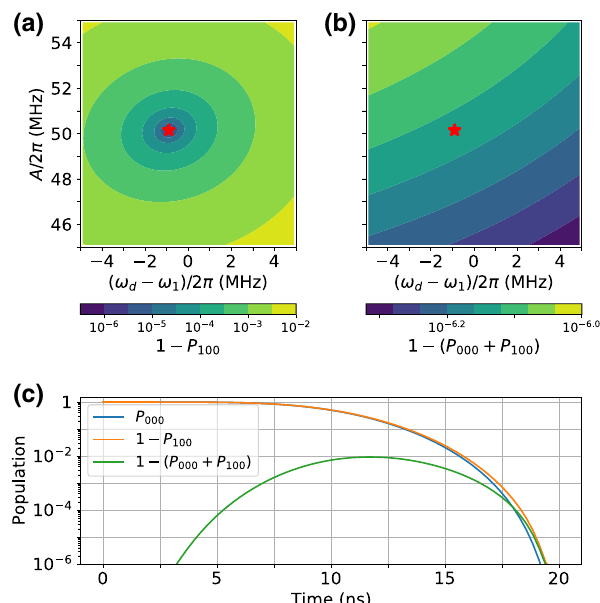
FIG. 14. Tune-up procedure for the single-qubit X gate. (a) Population error 1 − P 100 as a function of the driving amplitude A and the driving detuning (ω d − ω 1 ) for the two-qubit system initialized in state | 000 (cid:2) , and the fixed gate length t g = 20 ns. (b) Same as in (a), instead showing the leakage 1 − ( P 000 + P 100 ) versus the driving amplitude A and the driving detuning (ω d − ) for the single-qubit gate operations. (c) System dynamics ω 1 during the gate operation with the optimal parameter set indi- cated by the red stars in (a),(b) where both the population error and the leakage are suppressed below 10 − 6